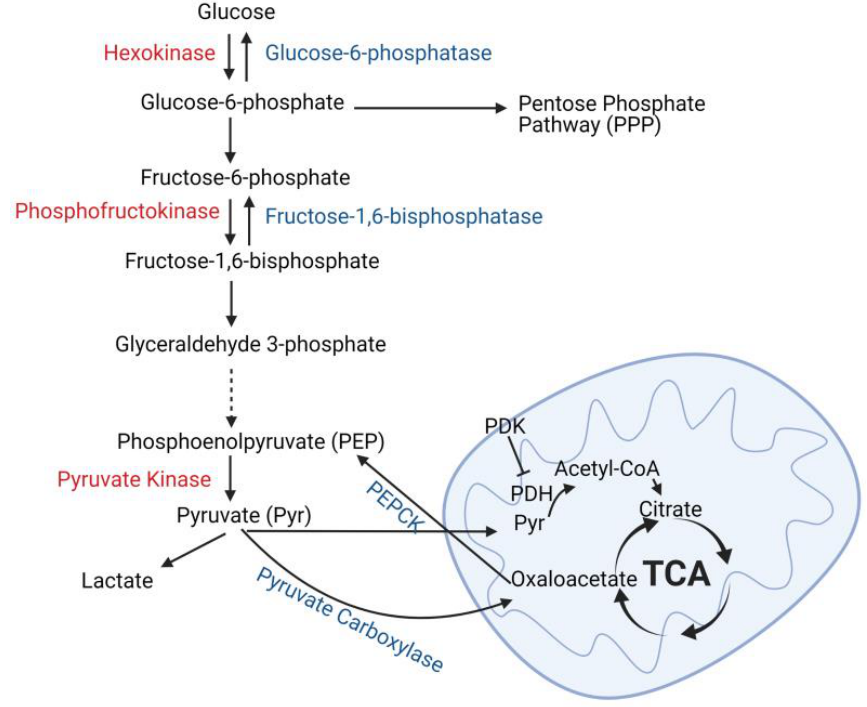
Figure 2. Glucose metabolism and production in the kidney tubules. Glucose is metabolized to glucose-6-phosphate which can enter the pentose phosphate pathway or be metabolized to pyruvate (glycolysis). The key enzymes necessary for glycolysis are listed in red, and these enzymes are predominately expressed in distal tubules of the kidney. Pyruvate can either be converted into lactate (anaerobic glycolysis) or enter the mitochondria where it is converted into acetyl-CoA by pyruvate dehydrogenase (PDH) and oxidized by the tricarboxylic acid (TCA) cycle. Enzymes associated with gluconeogenesis are shown in blue and their expression in the kidney is restricted to proximal tubules. Phosphoenolpyruvate carboxykinase (PEPCK), pyruvate dehydrogenase kinase (PDK). Created with